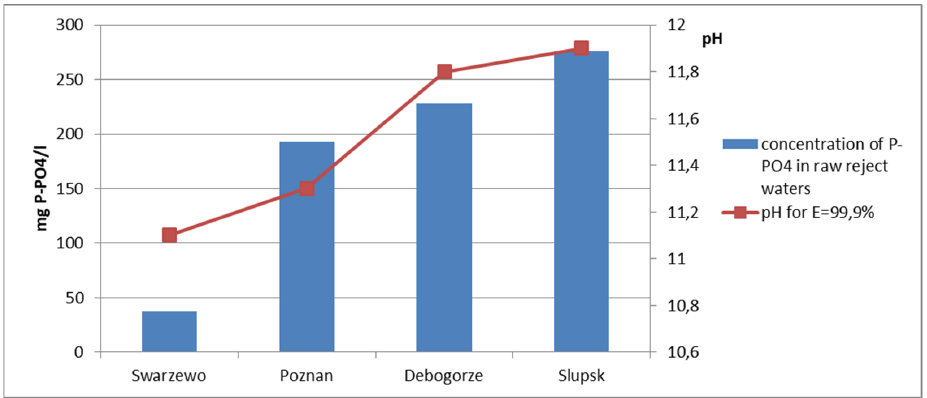
Figure 7. Relationship between phosphate concentration values in raw wastewater and pH achieved during phosphate precipitation (Efficiency E = 99.9%). during phosphate precipitation (Efficiency E =